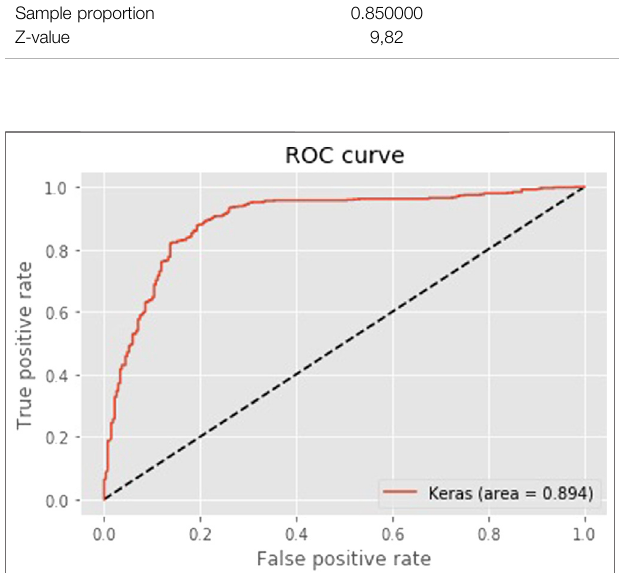
FIGURE 8 | ROC curve for RNN model for classifying negative OCRs from non-negative